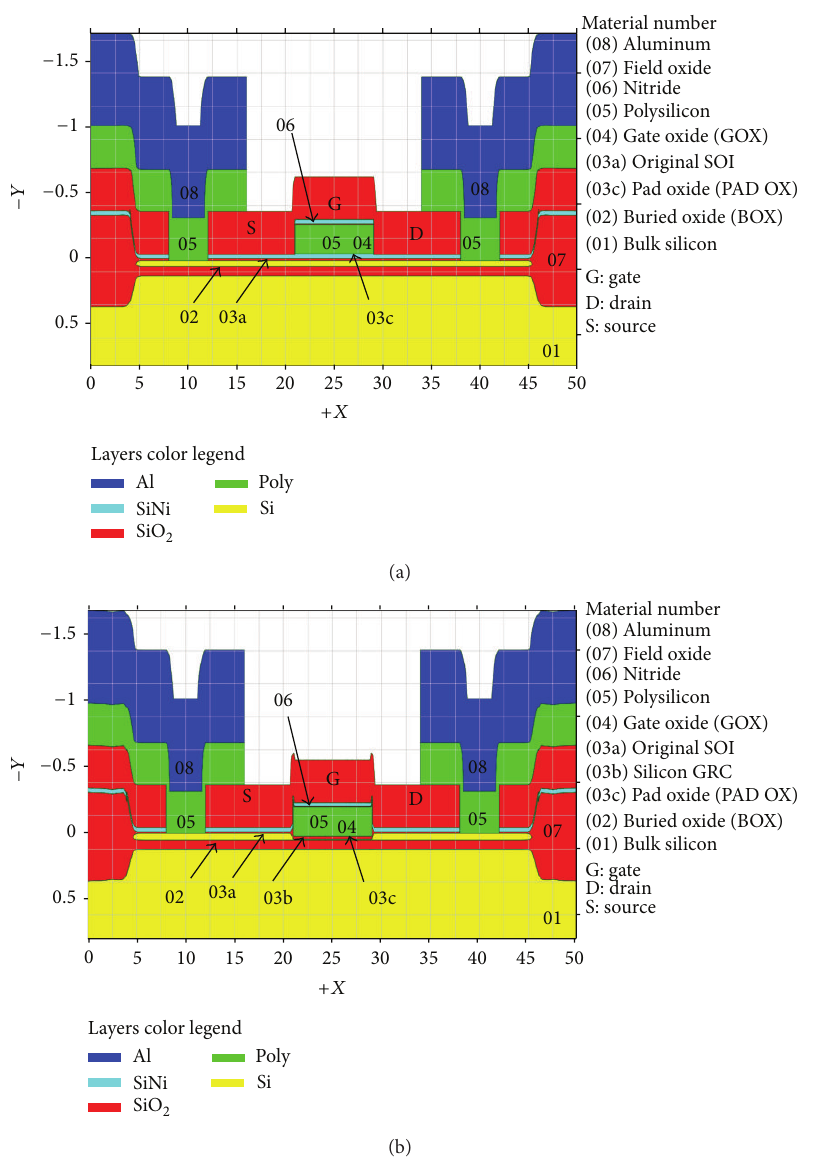
Figure 1: (a) 2-dimensional TCAD process simulation of the UTB device (scales are microns). (b) 2-dimensional TCAD process simulation of the GRC device (scales are